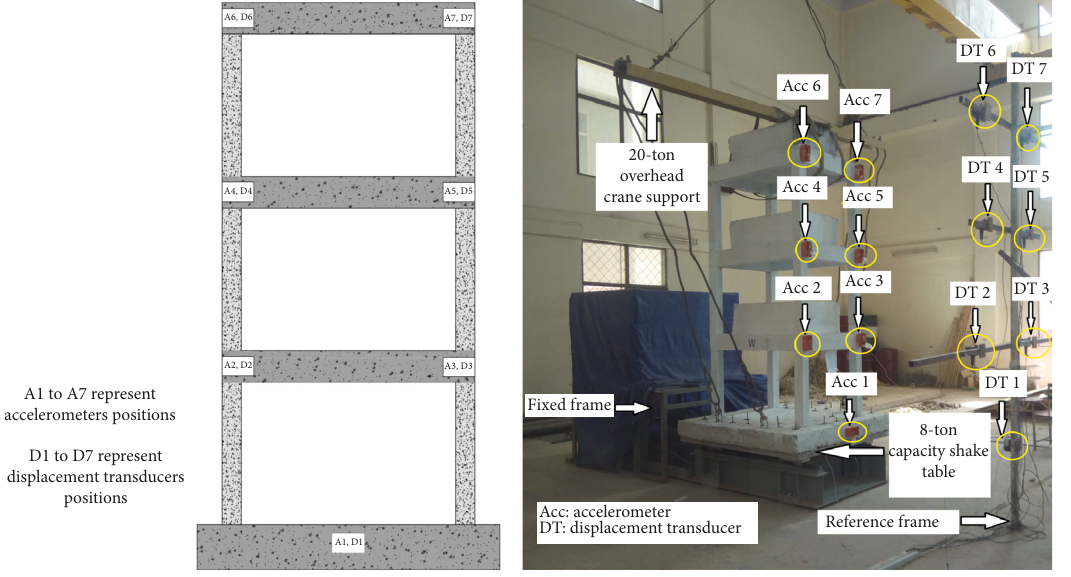
Figure 4: Test model instrumentation